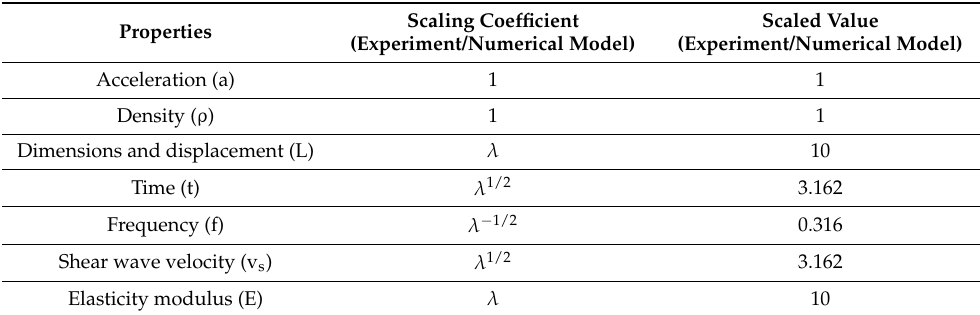
Table 2. Considered scaling coefficients.